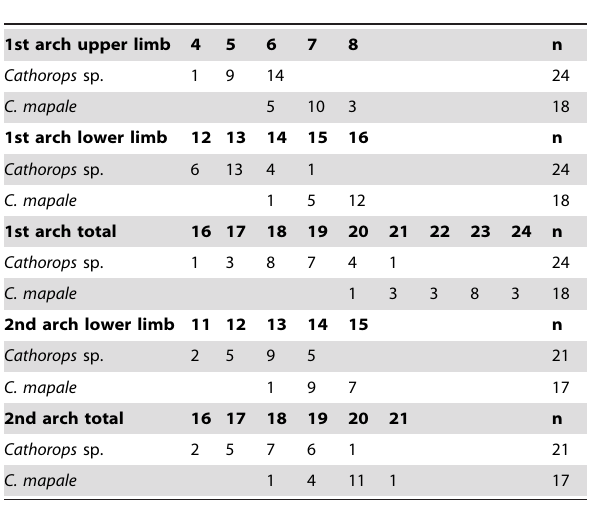
Table 2. Frequency table summarizing best meristic variables differentiating lineages within the Cathorops mapale